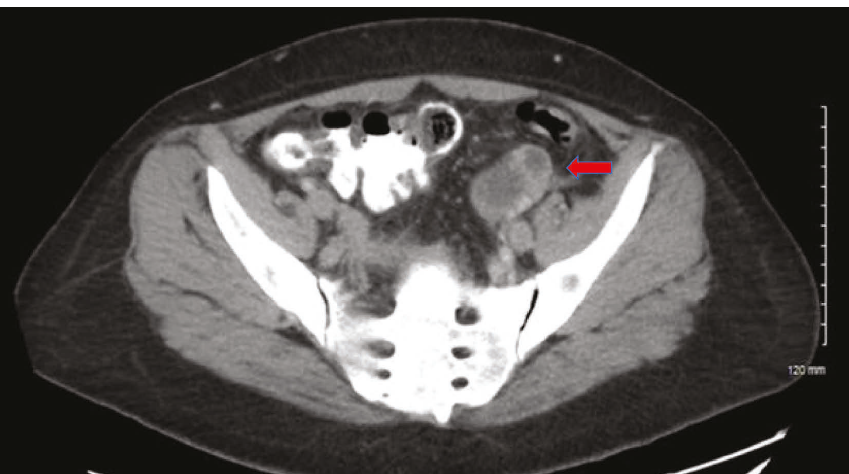
Figure 2: Transverse view of the lesion within the left adnexa, which contains a thin septation measuring 4.3cm and adjacent free fluid extending to the posterior